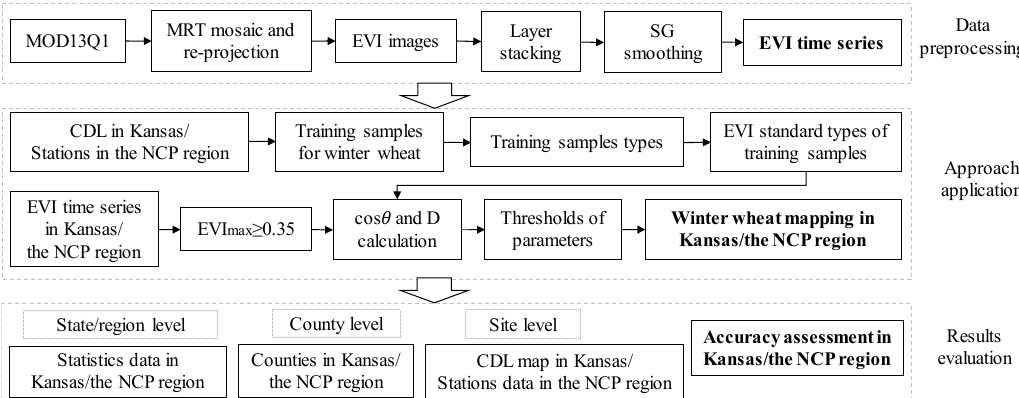
Figure 2. Overall process diagram of this study.